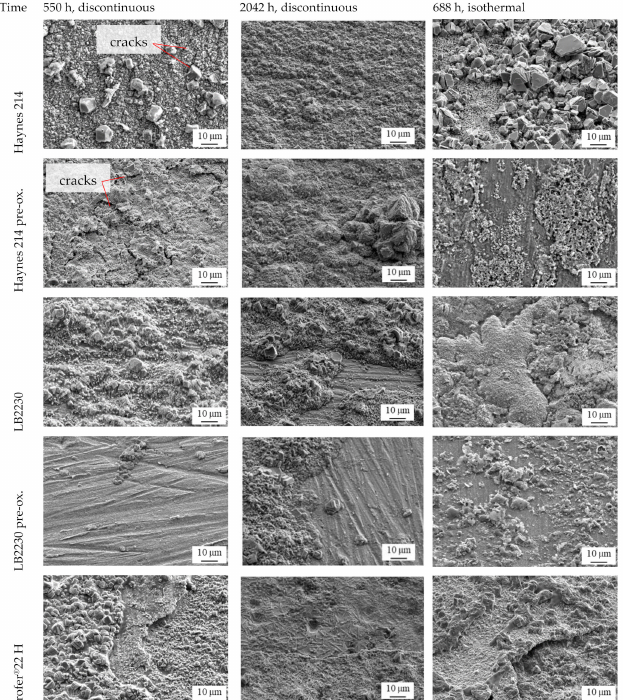
Figure 4. Scanning electron micrographs of the specimen surfaces after 550 h ( left ), 2042 h ( middle ) of discontinuous and 688 h of isothermal ( right ) corrosion testing in solar salt at 600 ◦ C.